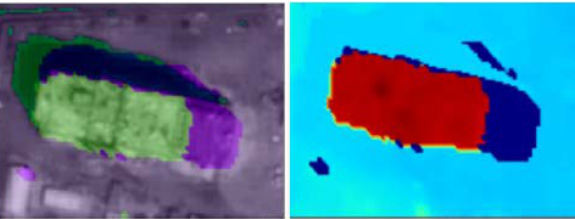
Figure 4. Left: light green: Building, dark green: shadow, light purple: ground, dark purple: void, right voids coincident with shadows are filled by median value of background (remaining voids are in dark